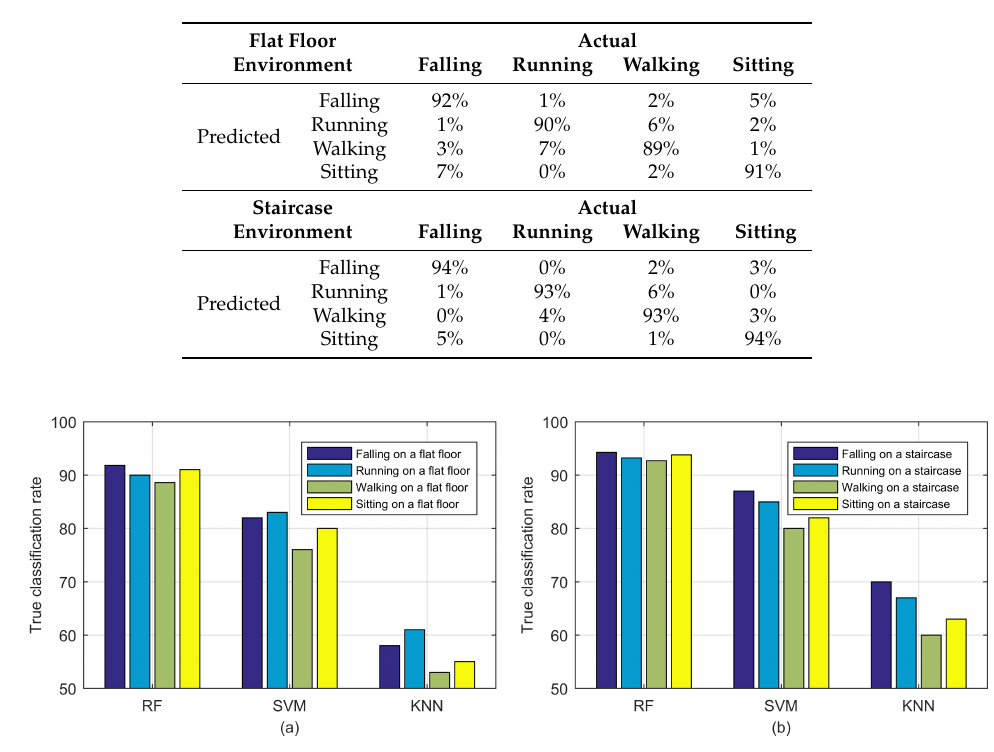
Table 5. Confusion matrix of fall detection results.